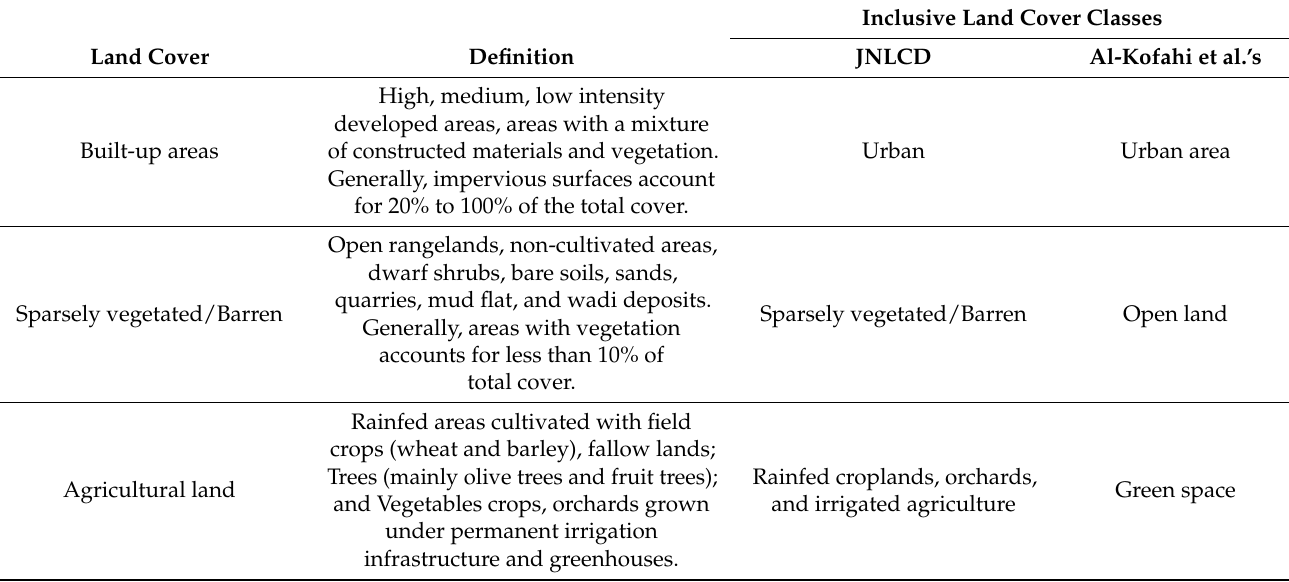
Table 2. Land use/cover classes used in this study. Classification was based on modified Anderson Level I. Inclusive land cover classes from JNLCD and previous land cover maps for the study are noted.